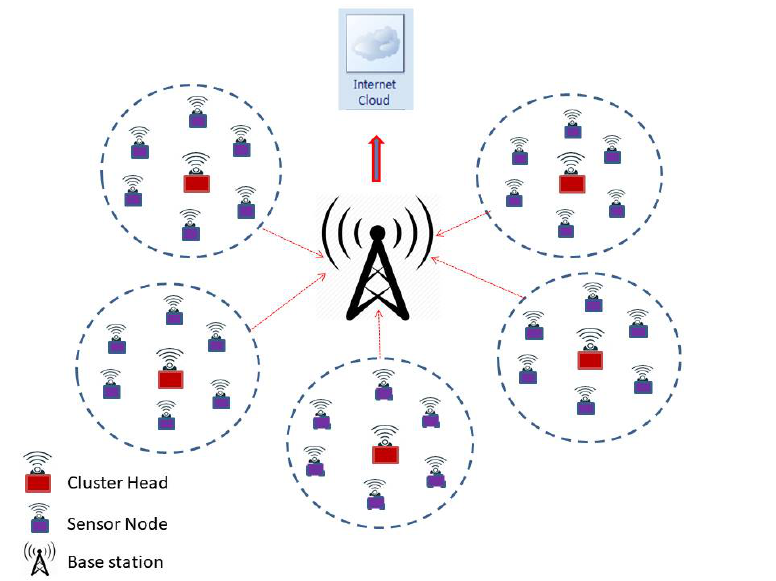
Figure 1. A typical wireless sensor networks (WSN) uses clustering technique for data communication from nodes to